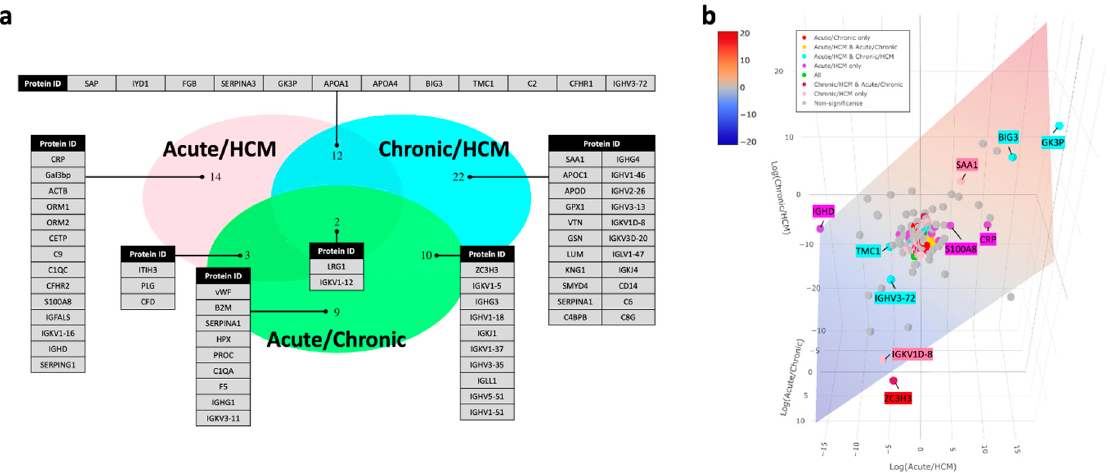
Figure 2. Highlighted proteins in differential expression analysis. ( a ) Triple Venn diagram summaris- ing the differentially expressed proteins unique and overlapped between chronic HFpEF vs. HCM, acute HFpEF vs. HCM and acute vs. chronic HFpEF. ( b ) Three-dimensional plot of fold changes (Log 2 -transformed) of all identified proteins, with a regression plane filled with colour indicator of log 2 -fold